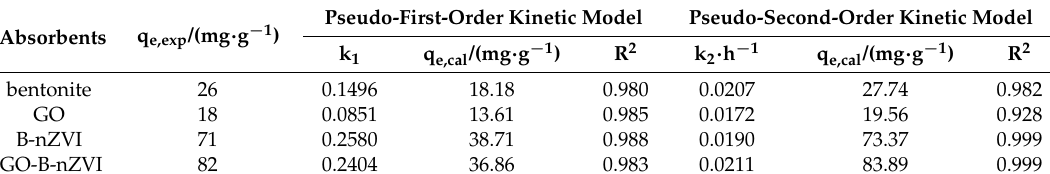
Table 3. Pseudo-first-order and pseudo-second-order kinetic model of the relevant parameters.